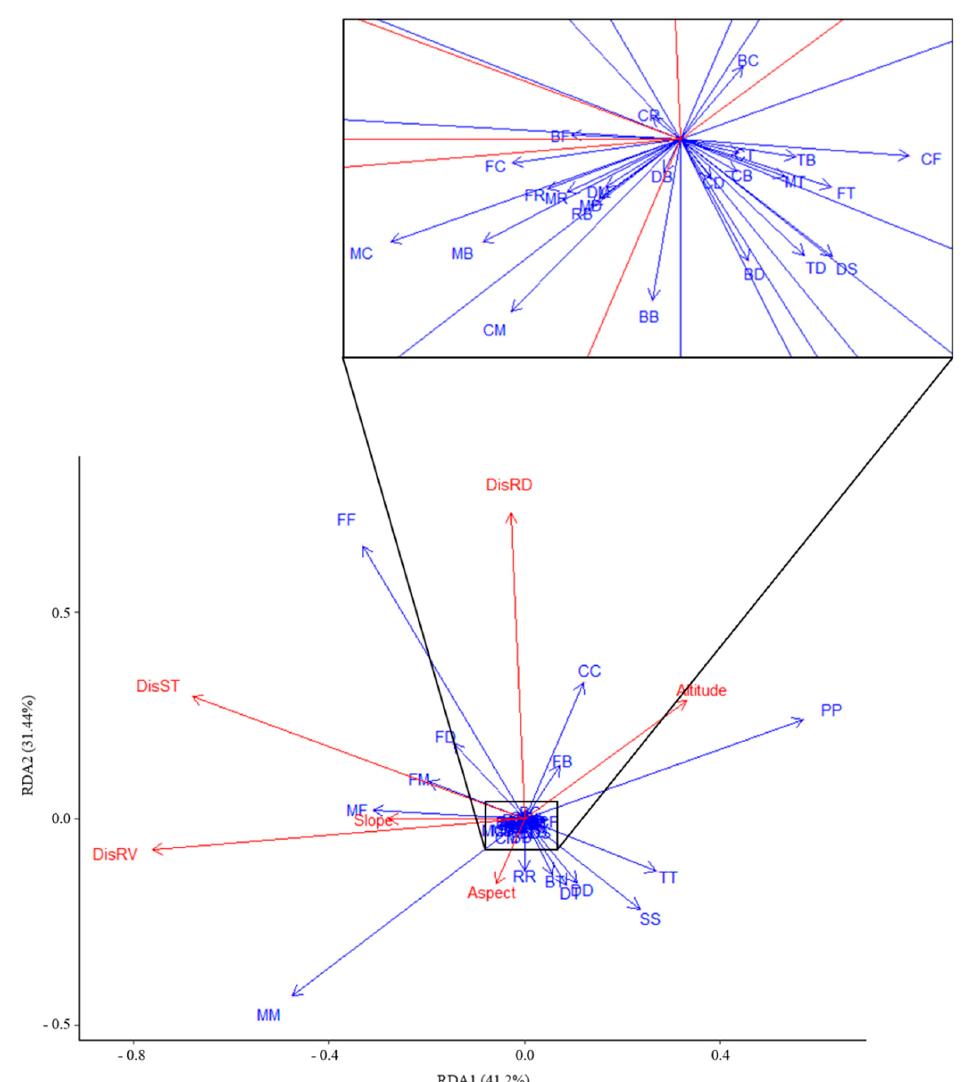
Figure 9. RDA ordination of land-use change trajectories (blue arrows) in relation to environmental variables (red arrows) for 2009–2019. DisRV: distance to rivers; DisRD: distance to roads; DisST: distance to settlements. Arrows represent relative values of environmental variables and land-use change trajectories. Correlations between environmental variables and land-use change trajectories are indicated by the cosine of angles between the corresponding arrows, with <90° indicating a positive correlation and >90° a negative correlation. With projection of arrows for land-use change trajectories into arrows for corresponding environmental variables, the distance from the origin to the projection point indicates the relative value of the environmental variable where land-use change is most likely to occur.